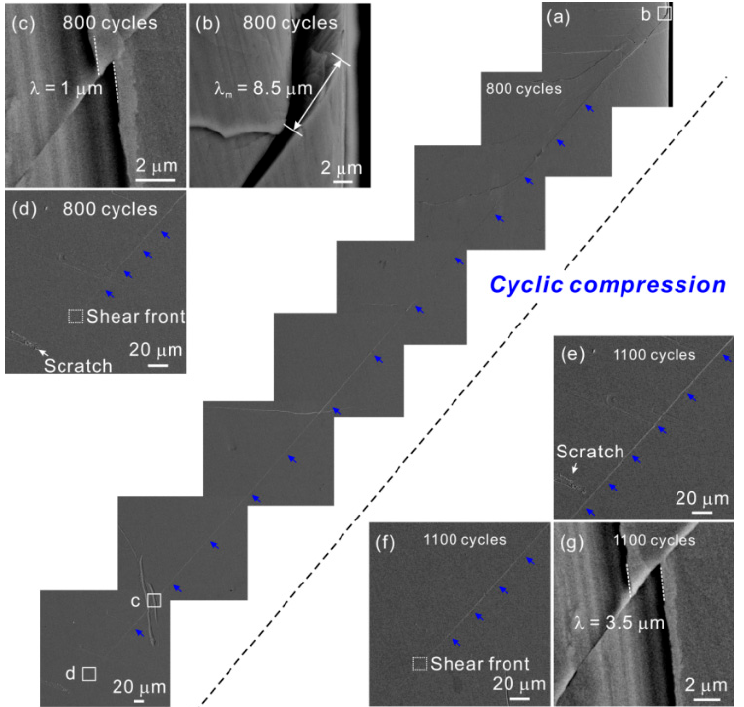
Figure 4. Shear band propagation after different cycles of cyclic compression [45]. ( a ) Overall apearance of the inserting shear band after 800 cycles. ( b ) Measurement of maximum shear offset after 800 cycles. ( c , g ) Measurement of the local shear offset at the same position of shear band after 800 and 1100 cycles, respectively. ( d – f ) Growth of the shear band tip from 800 cycles to 1100 cycles. After 800 cycles, one shear band stops inside the specimen (see Figure 4a,d). A straight scratch intersecting with the shear band is sheared off by the shear band and the value of local shear offset is ~1 µ m. After 1100 cycles, this shear band continues to grow along the fixed shear direction, but still not transects the specimen, as evidenced by the position of shear front (see Figure 4f). The value of the local shear offset in the same position of the shear band increases to ~3.5 µ m (see Figure 4g). It seems that the shear band progressively grows under cyclic